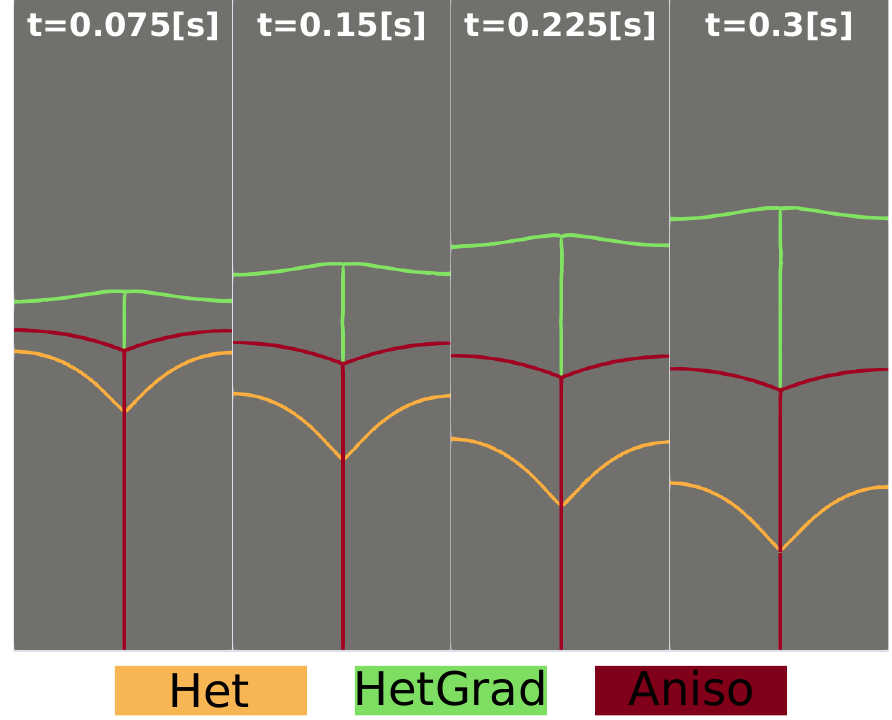
Figure 8. Evolution of the interfaces at different time steps of the three models and the initial microstructure colored in